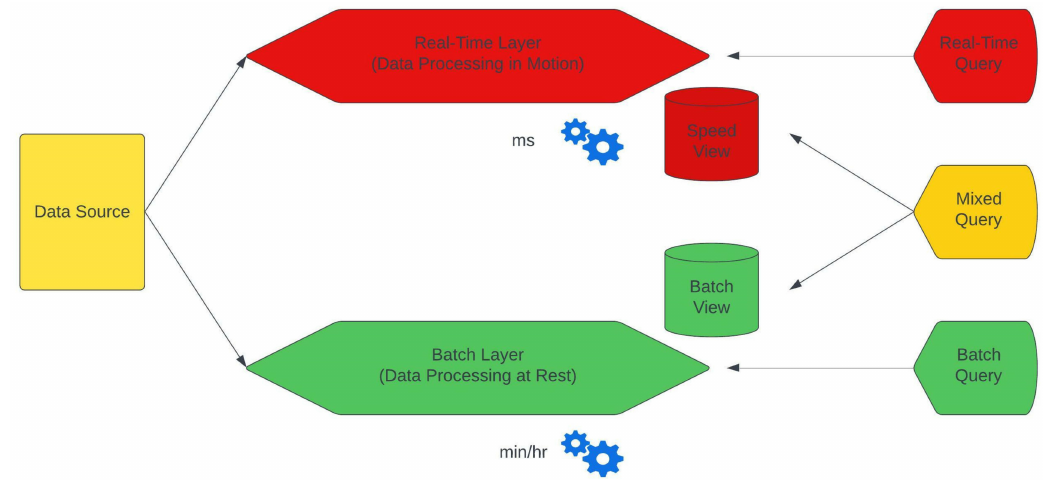
Figure 4. Lambda